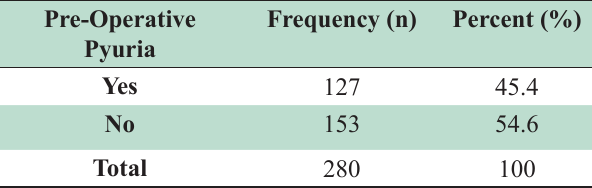
Table-I: Frequency of Pre-operative Pyuria in Patients with NMIBC undergoing TURBT with Post-operative Instillation of BCG